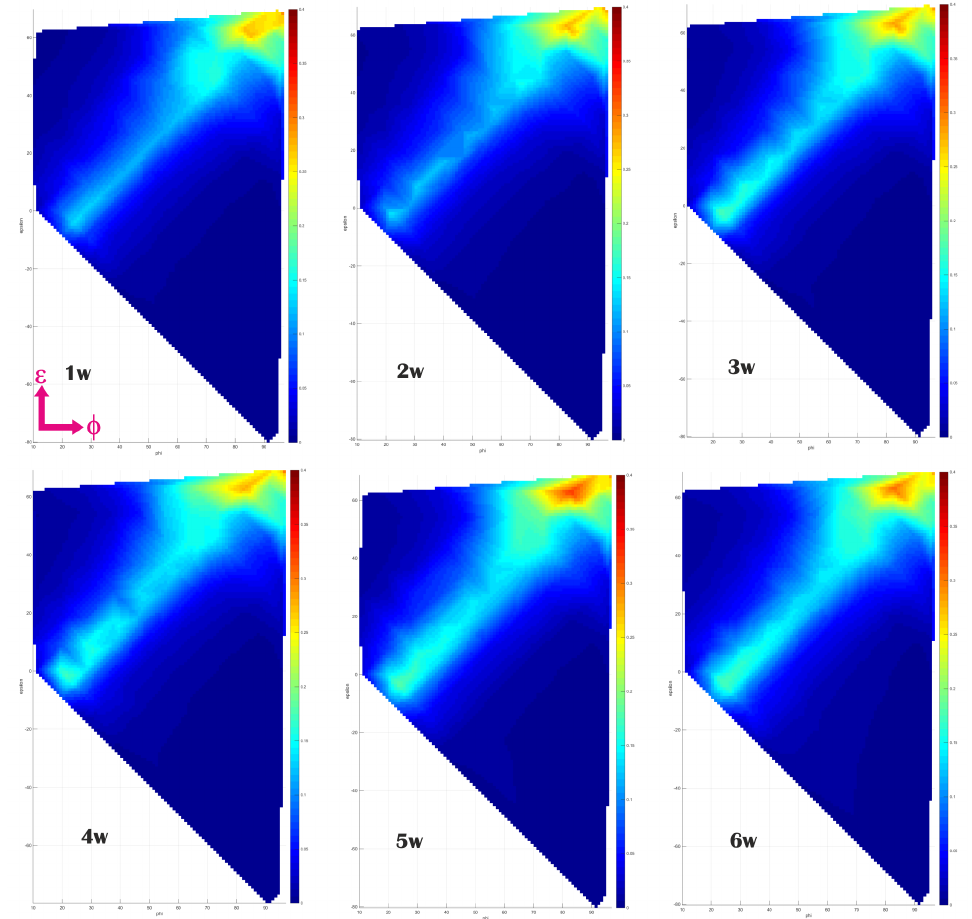
Figure 6. Series of surface reflectance representations demonstrating effect of accelerated weathering on optical properties of